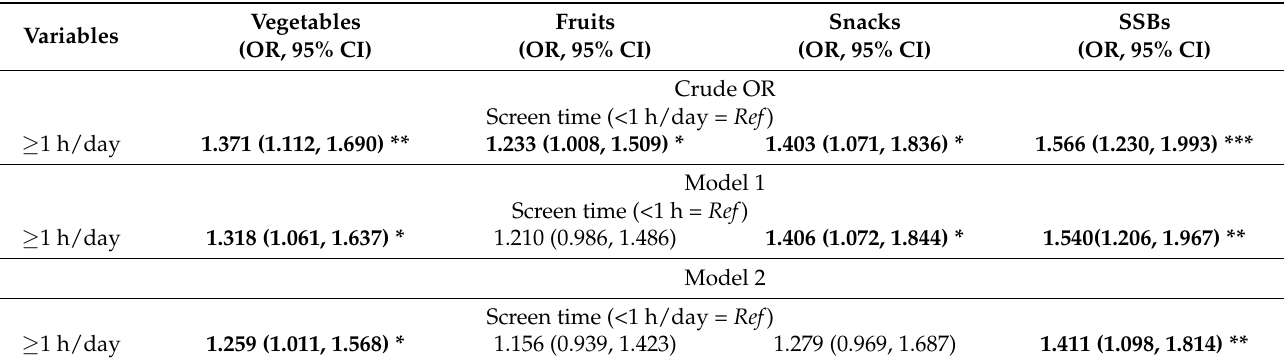
Table 3. Binary logistic models of the association between screen time and consumption of FV, snacks and SSBS among preschool children ( n =